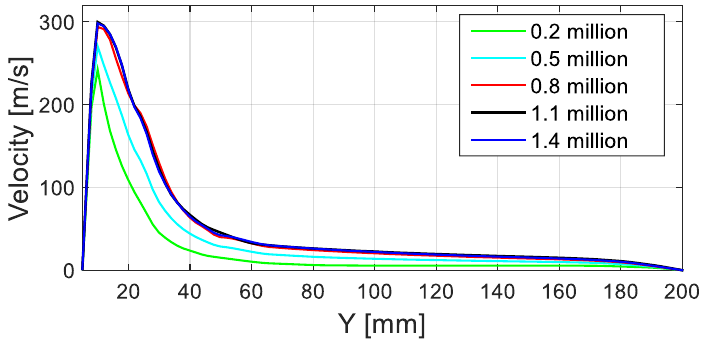
Figure 4. Comparison of air velocity along air spraying gun axis for five kinds of grids: 0.2, 0.5, 0.8, 1.1, 1.4 million.